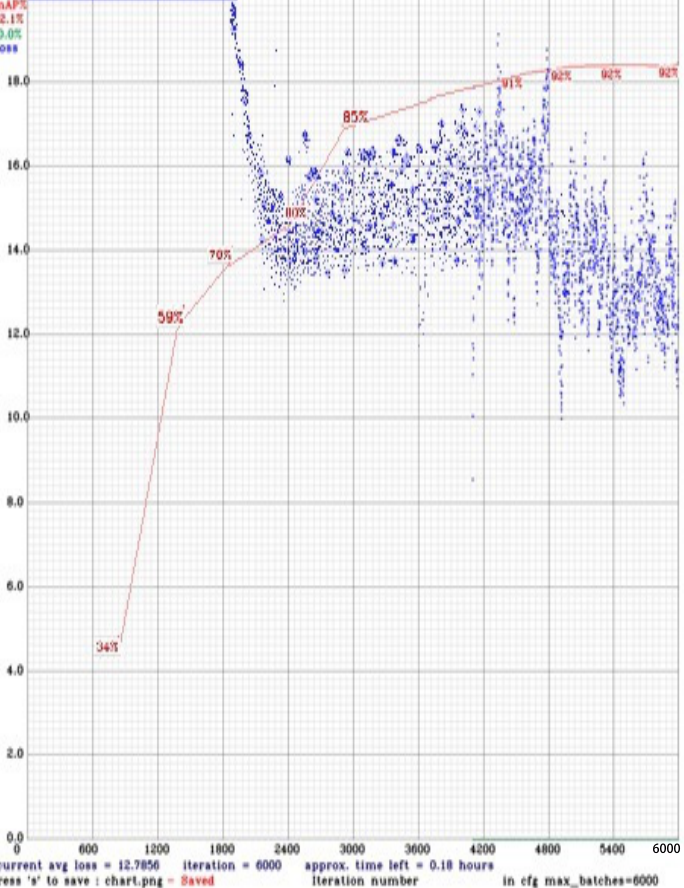
Figure 11. Tesla T4-trained best model graph of mAP vs. avg. loss: model trained with a subdivision of 8, image resolution of 512 × 512, number of iterations 6000, object smoothness as 0 and Scale x y as 1.05.